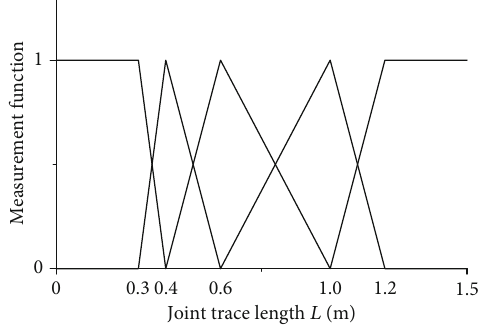
Figure 5: Uncertainty measurement function of joint trace